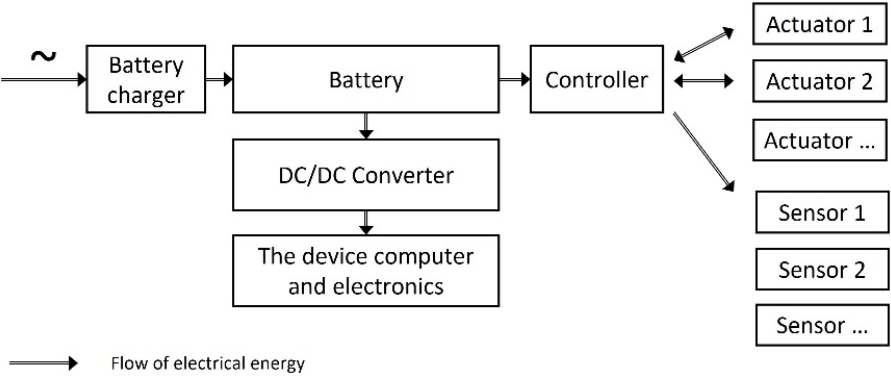
Figure 1. Structure of a mobile device power supply system.